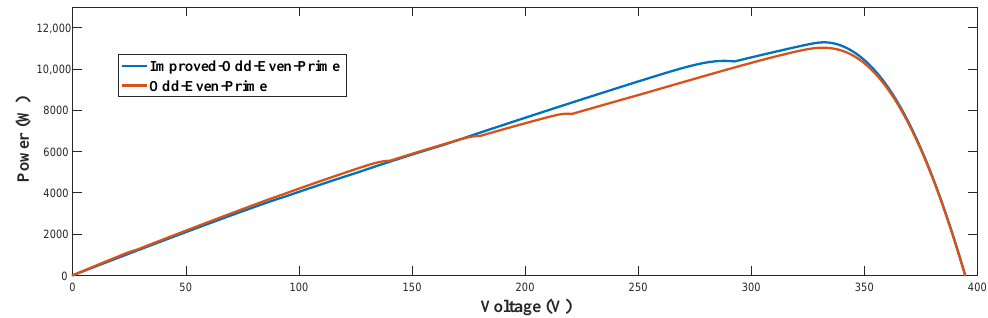
Figure 9. Voltage–power characteristics of 9 × 9 PV array for case-4 (Bottom-Right) PSC. For different values of array current, the array voltage and power are calculated and noted in Table 5. From Table 5, it is clearly understood that the maximum value of power for OEP is 60.3 V m I m and the maximum value of power for IOEP is 61.2 V m I m . Table 5. GMPP for 9 × 9 PV array for Case-4 (Bottom-Right) PSC. Odd-Even-Primve Improved-Odd-Even-Primve